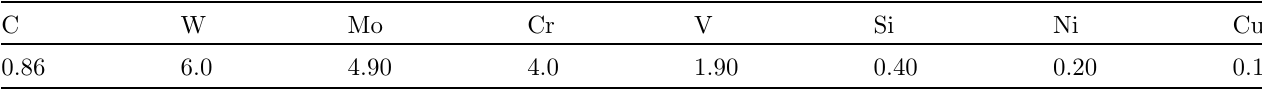
Table 2. AISI M2 HSS tool signature. Back rake